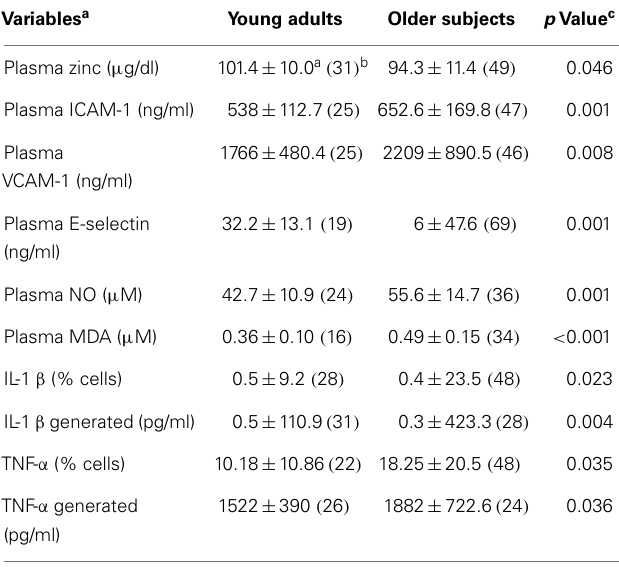
Table 3 | Effect of zinc and placebo supplementation on plasma oxidative stress markers .